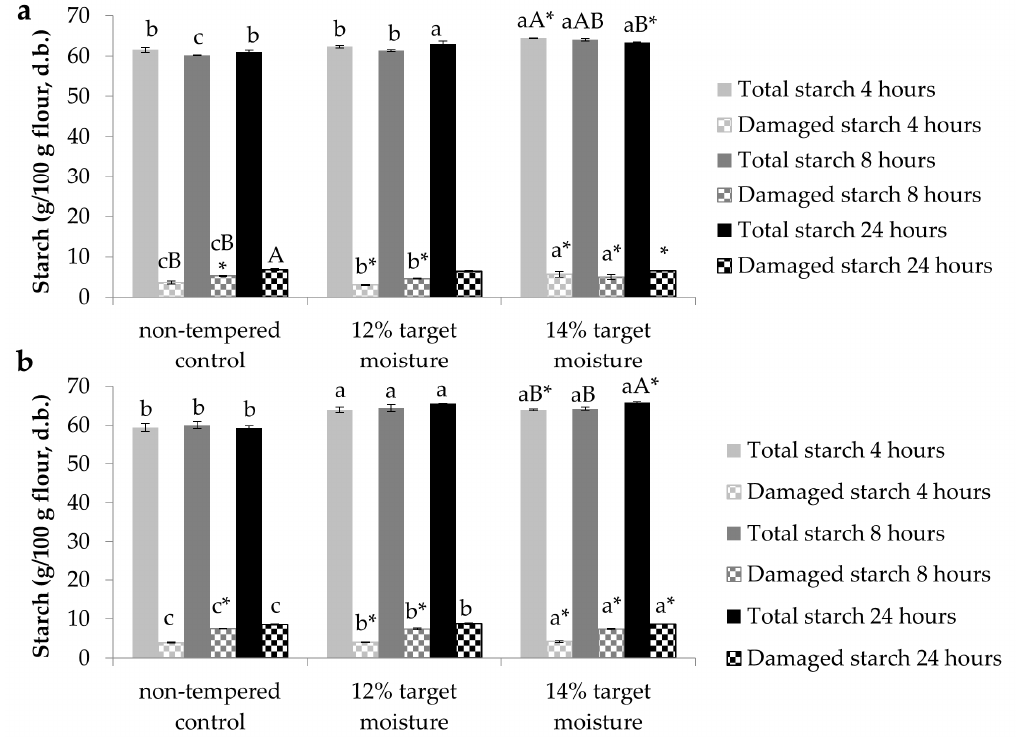
Figure 1. Starch and damaged starch contents in ( a ) samples incubated at 30 °C and ( b ) samples incubated at 45 °C. Lowercase letters reflect differences according to target moisture, uppercase letters illustrate differences due to incubation time, and asterisks represent differences due to incubation temperature.